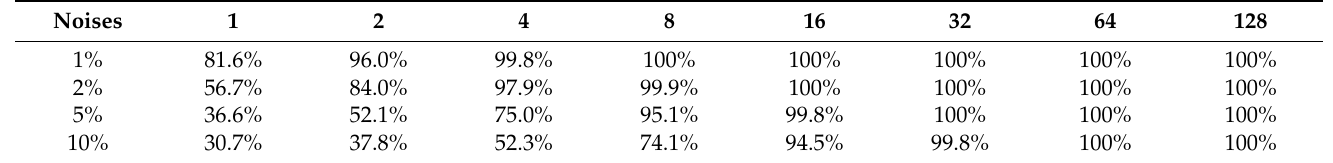
Figure 6. The activation plots of the AVS for 32-pixel object motion direction detection within the background with 10% separated noises. Table 3. Detection results of the AVS within the background with connected